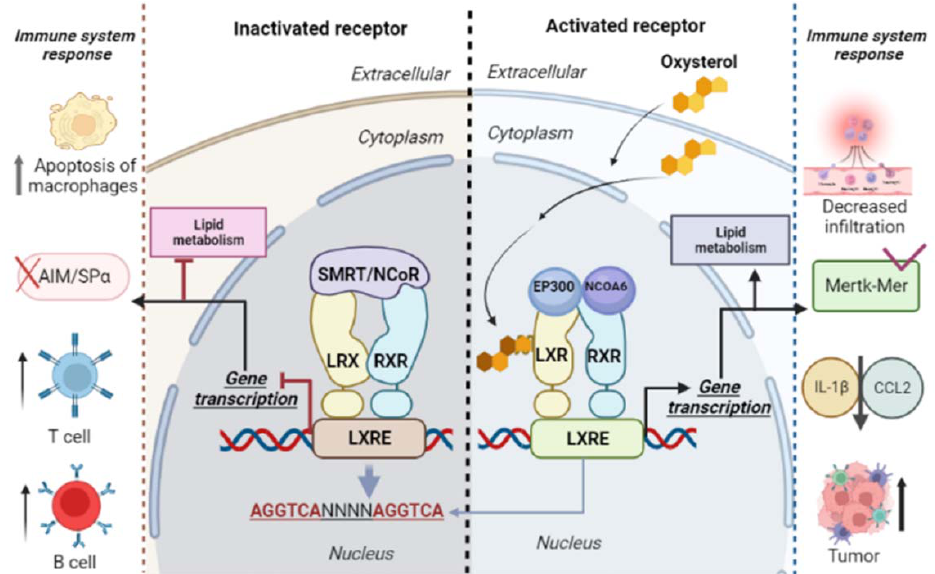
Figure 2. Liver X receptors (LXRs) and retinoid X receptors (RXRs) form heterodimers and bind to LXR response elements (LXREs). The LXR/RXR binding regions are composed of repeated sequences of AGGTCA and four nucleotides (NNNN). This region is responsible for the regulation of activated target genes via LXR/RXR. Inactivation of the LXR/RXR complex occurs by binding with corepressors (nuclear receptor corepressor (NcoR), retinoic acid silencing mediator, and thyroid hormone receptor (SMRT)). In the presence of oxysterols, coactivators (nuclear receptor coactivator 6 (NCOA6) and histone acetyltransferase p300 (EP300)) bind to the LXR/RXR complex, activating the expression of genes involved in lipid metabolism and in innate and cellular immune response. Both the inactivation and the activation of LXR receptors are associated with immune responses.